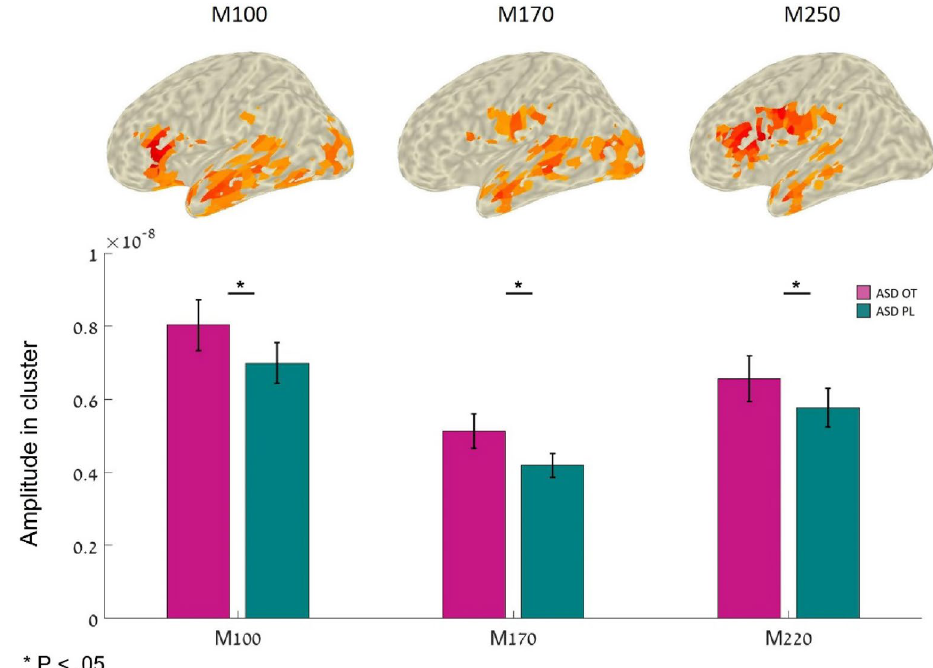
Figure 4. Main effect of OT is source-level. In general, compared to PL, OT increased neural activation in frontal, temporal, and occipital regions, regardless of the content (social/non-social) of the presented stimuli. Top panel–significant differences in each of the preselected components of interest between OT and PL sessions. Significant differences were observed in the left hemisphere only. Bottom panel–average power in the significant clusters for each group separately. Vertical lines represent mean values ± 1